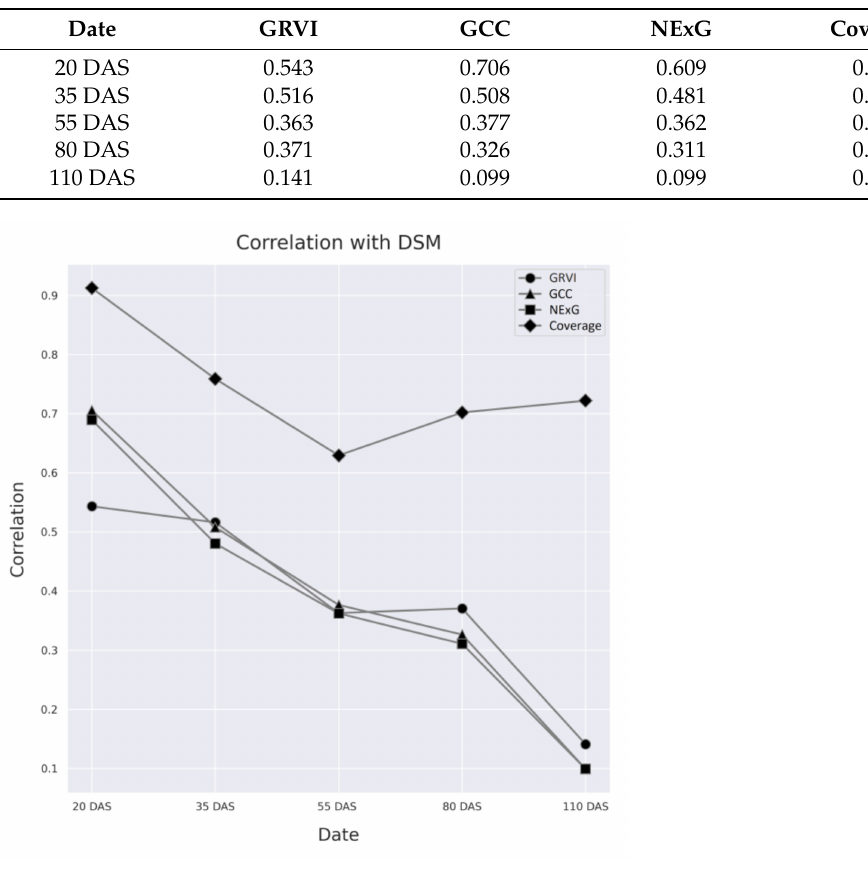
Table 4. The Pearson correlation values between VI data and canopy coverage and the respective DSMs at the resolution of the reference grid (10 × 10 m 2 ).